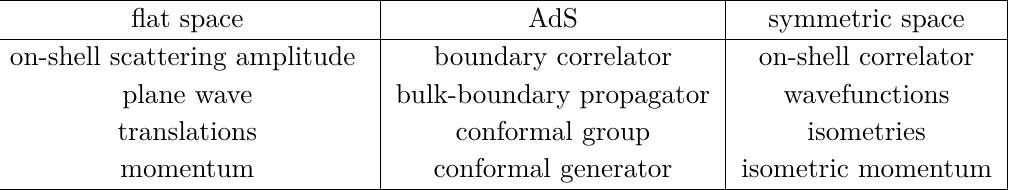
Table 1 . Dictionary for relevant quantities in flat space, AdS, and general symmetric